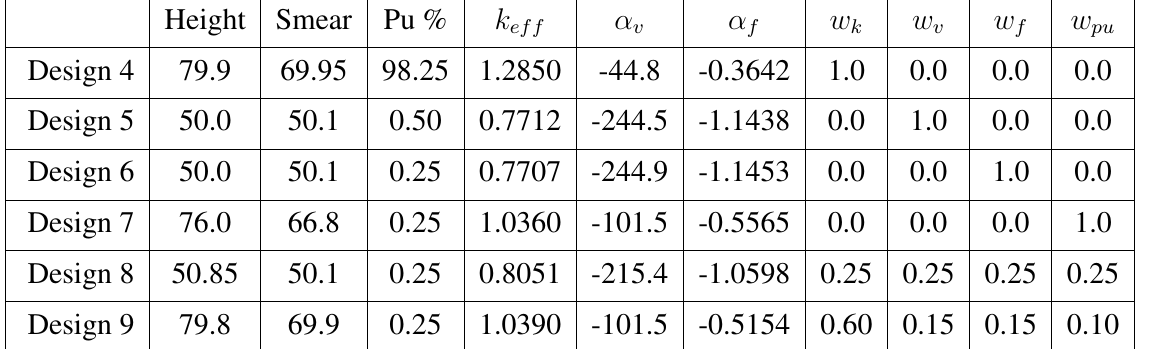
Table 6: Select Designs on Pareto front for SOGA using Weighting